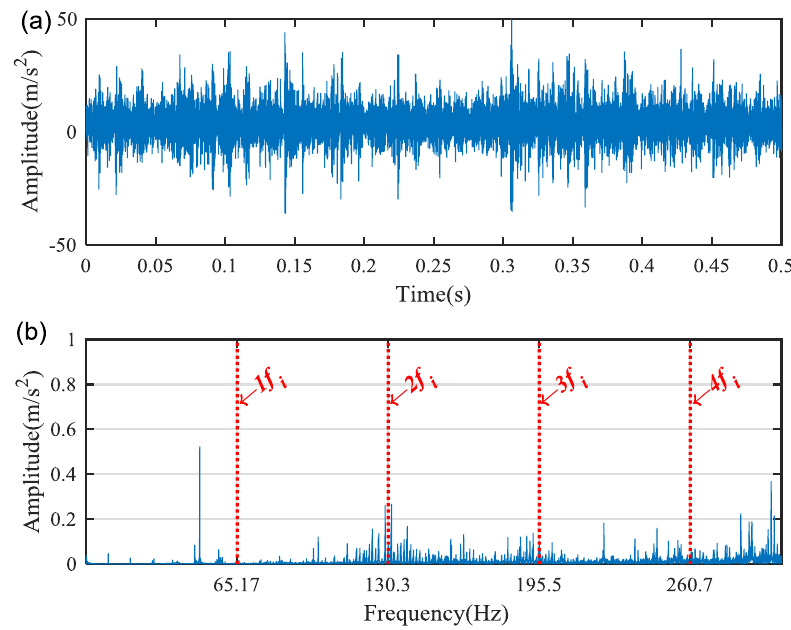
Figure 9. The raw vibration signal of the faulty bearing: ( a ) the waveform and ( b ) spectrum.